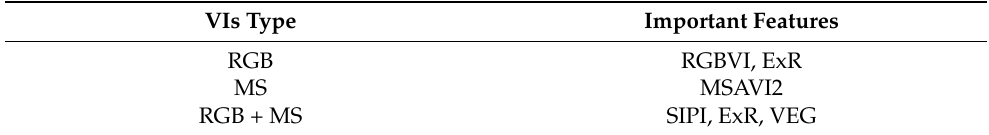
Table 8. Important features selected after data